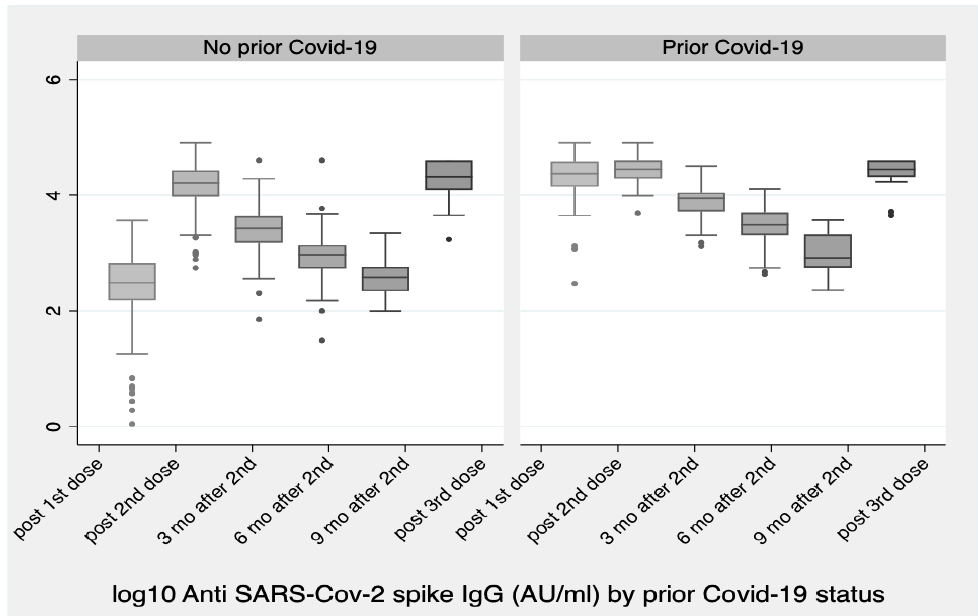
Figure 2. log10 Anti SARS-CoV-2 Spike IgG antibody levels by prior COVID-19 infection status at six selected time points over the course of the vaccination plan: up to three, six and nine months after its completion and one month after the 3rd dose. There was no significant difference between subjects with prior SARS-CoV-2 infection and subjects without history of infection ( p = 0.155). Eighteen subjects were infected with the Omicron variant (B.1.1.529) two to five Table 2. GMCs and corresponding 95% CIs of subjects infected after the 3rd dose versus subjects not infected after the 3rd dose over the course of the study. No significant differences were